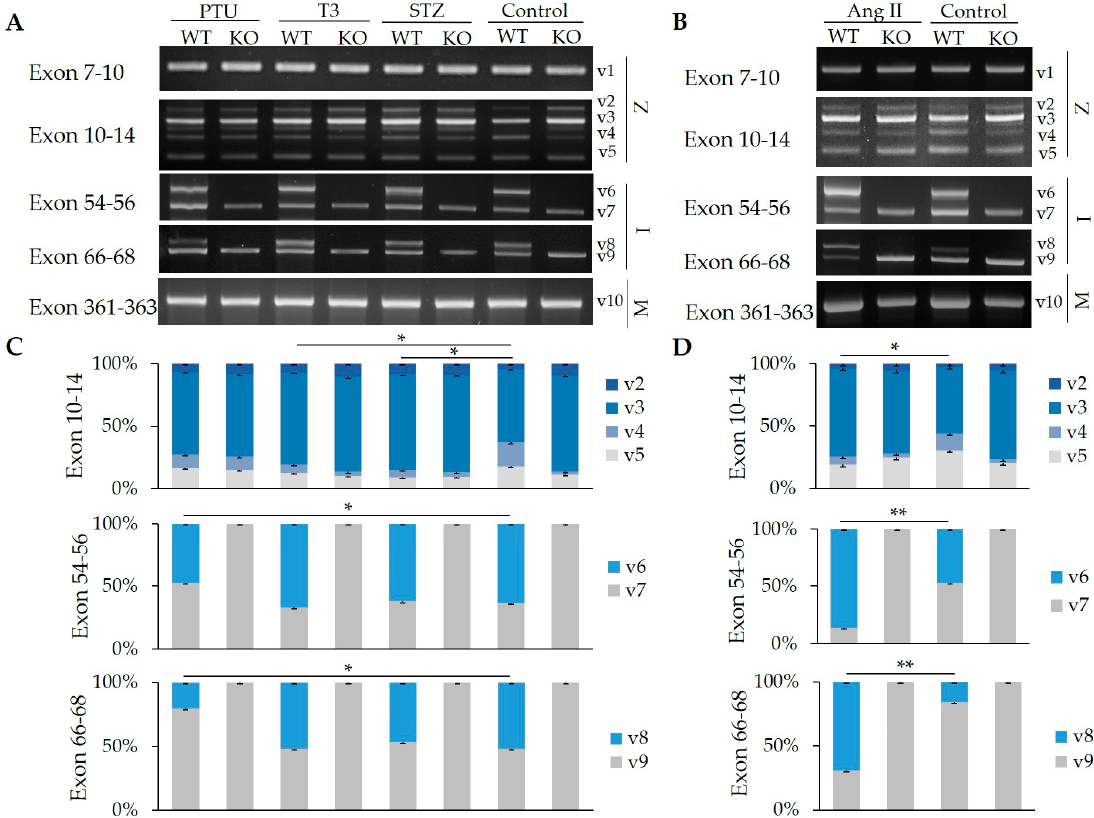
Figure 2. Z-, I-, and M-band titin splicing in WT and KO rats treated with propylthiouracil (PTU), triiodothyronine (T3), streptozotocin (STZ), and angiotensin II (Ang II). ( A ) RT-PCR results of Z-, I-, and M-band titin splicing with PTU, T3, and STZ; ( B ) RT-PCR results of Z-, I-, and M-band titin splicing with Ang II treatment. ( C ) Quantification of band density of different splicing variants amplified by primers spanning exons 10–14, exons 54–56, and exons 66–68 with PTU, T3, and STZ; ( D ) Quantification of band density of splicing variants amplified by primers spanning exons 10–14, exons 54–56, and exons 66–68 with Ang II treatment. Mean ± SE ( n = 3), * p < 0.05, ** p < 0.01. v, variants; 1–10, different variants; WT, wild type; KO, RBM20 knockout; Z, Z-band. I, I-band. M,